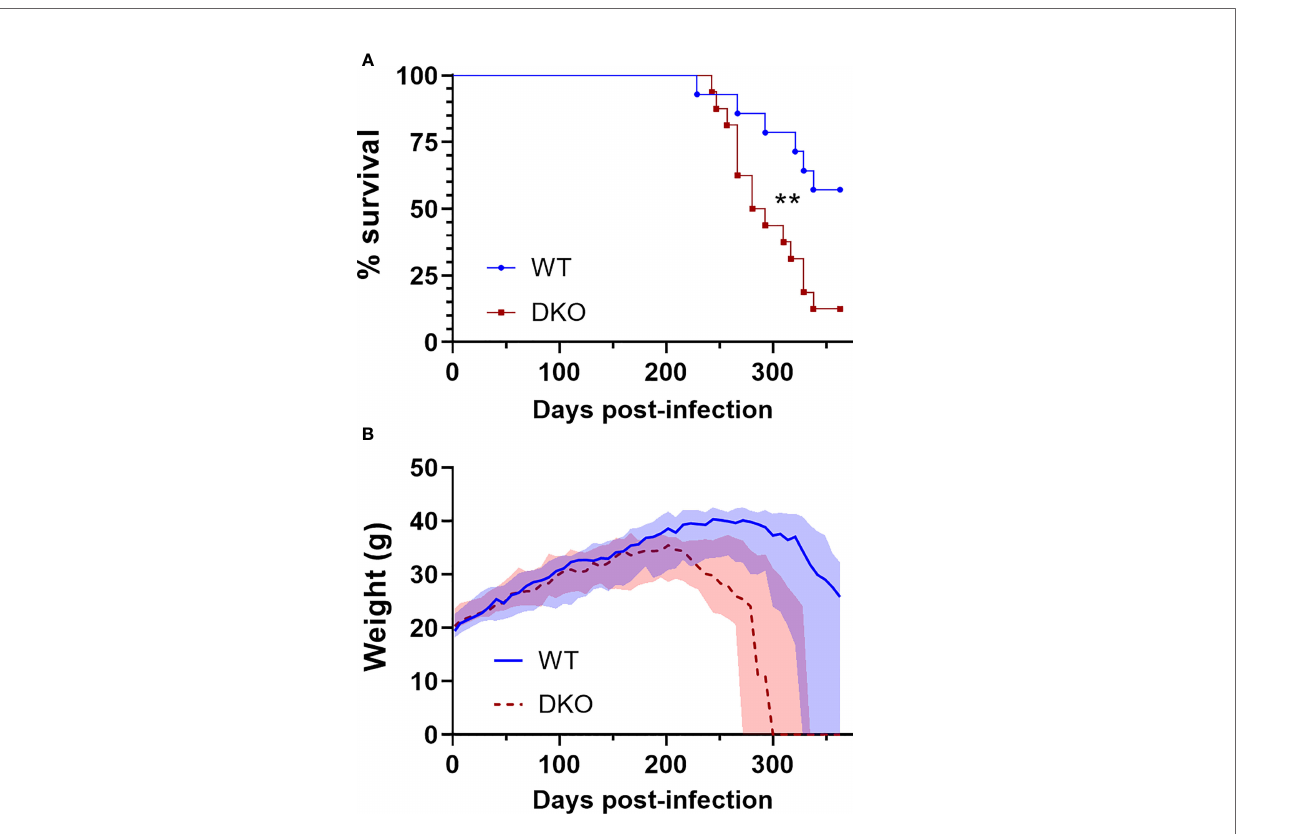
FIGURE 2 | Survival of DKO mice infected with Mtb in comparison to WT. (A) , percent survival. **p = 0.0076 by log-rank (Mantel-Cox) test. (B) , weight in grams; median (lines) +/- interquartile range (shading) are shown. Euthanized mice received a weight of 0 g. All mice were female. Median day 1 pulmonary Mtb load was 29 CFU. N = 14 and 16 for WT and DKO,